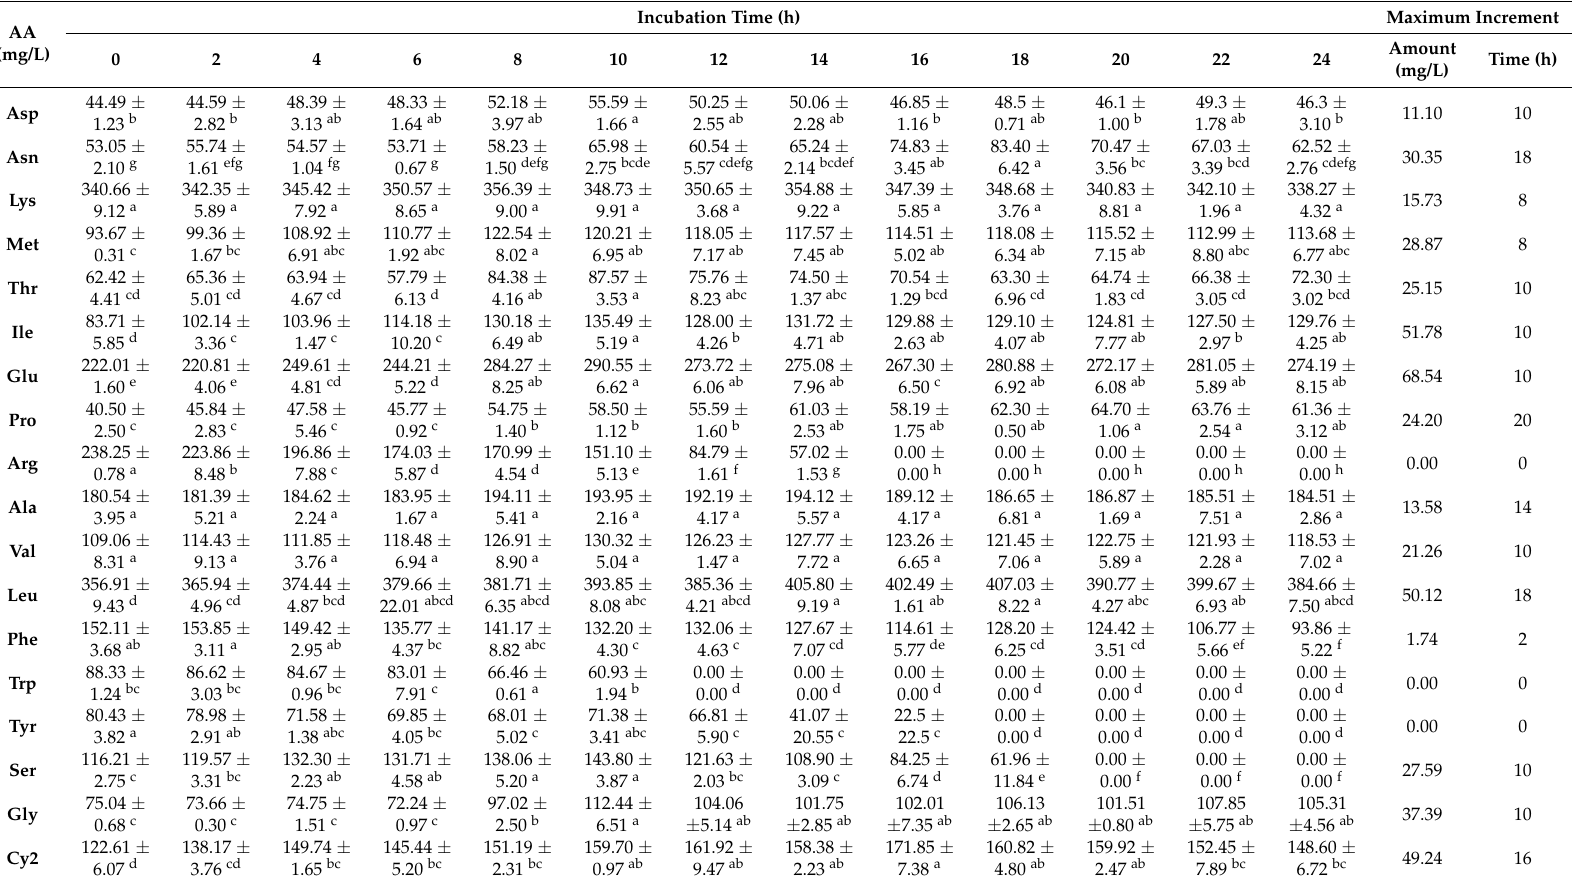
Table 1. The amino acid production profile of P. acidilactici